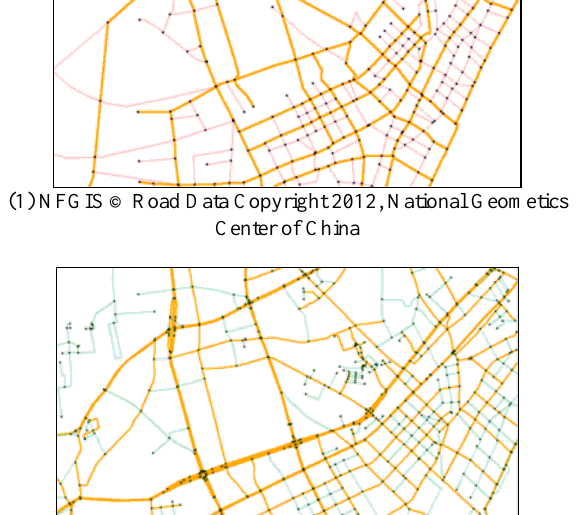
Figure 5. Matching result from a projected